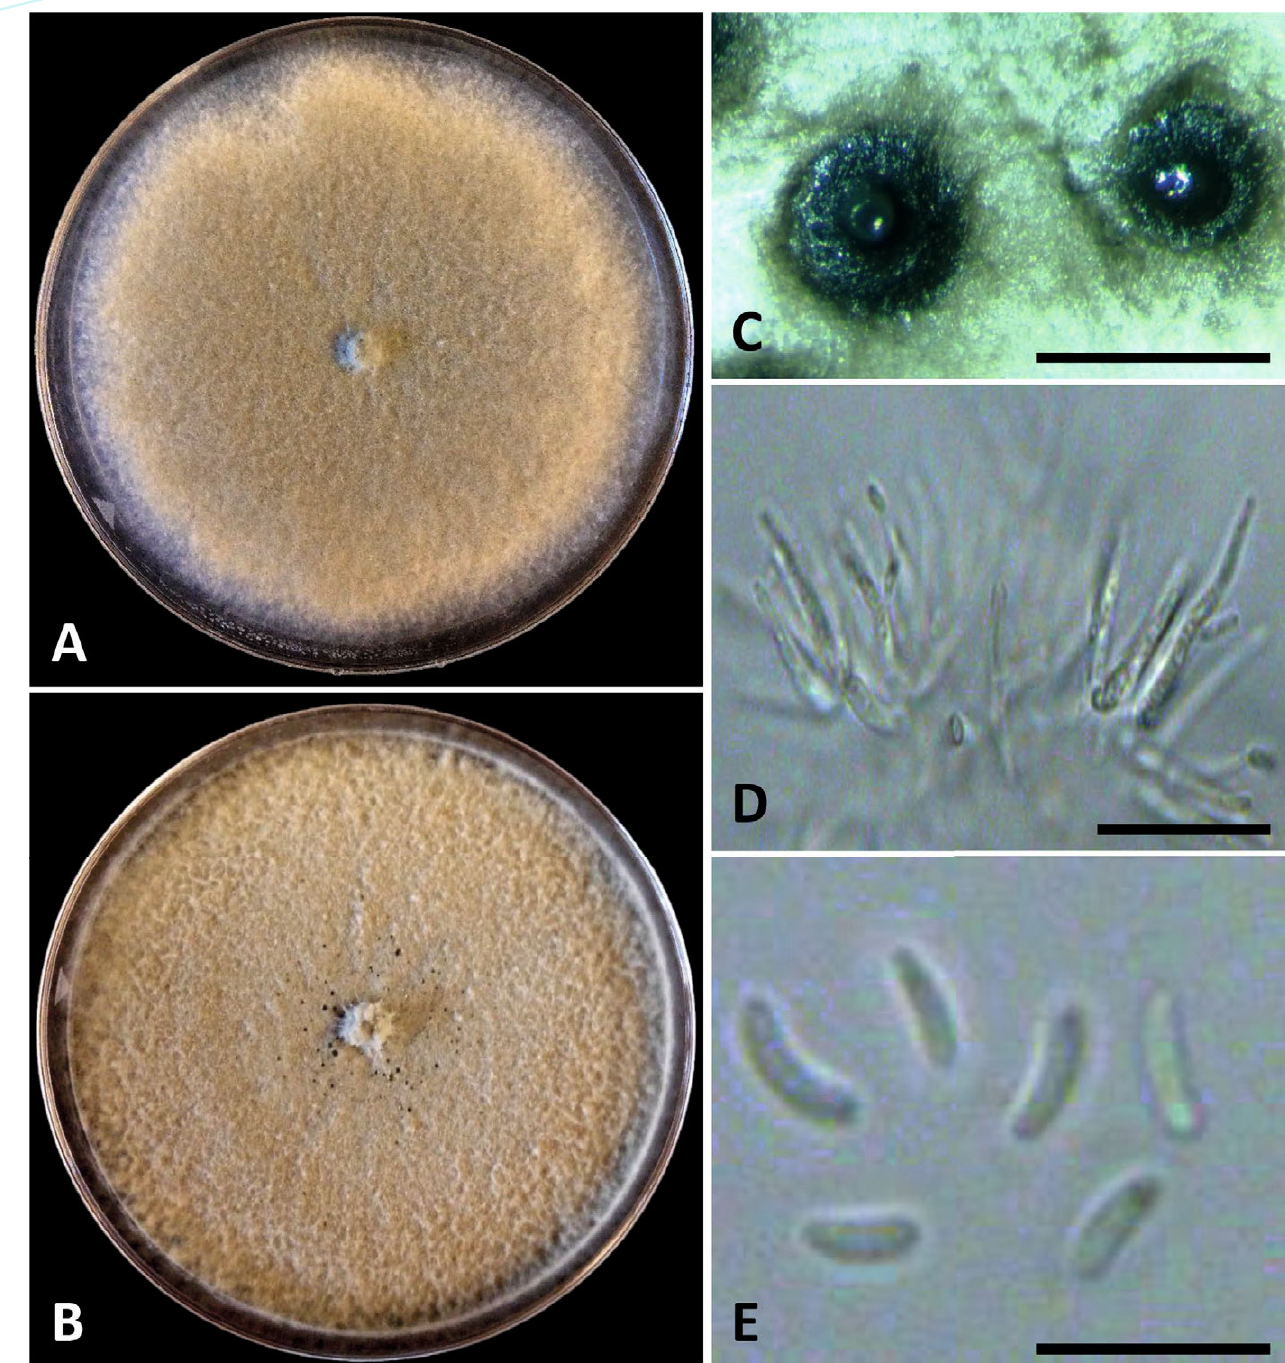
Fig. 14. Cytospora parapistaciae (ex-holotype culture CBS 144506). A. Seven-day-old PDA culture. B. Fourteen-day-old PDA culture. C. Pycnidia. D. (cid:2){(cid:4)(cid:17)(cid:11)(cid:21)(cid:11)(cid:4)(cid:18)(cid:14)(cid:4)(cid:10)(cid:13)(cid:7)(cid:2)(cid:9)(cid:17)(cid:21)(cid:2)(cid:20)(cid:23)(cid:9)(cid:6)(cid:13)(cid:17)(cid:8)(cid:4)(cid:5)(cid:7)(cid:2)(cid:19)(cid:4)(cid:17)(cid:11)(cid:21)(cid:11)(cid:4)(cid:25)(cid:13)(cid:17)(cid:4)(cid:5)(cid:7)(cid:2)(cid:19)(cid:13)(cid:23)(cid:23)(cid:7)(cid:28)(cid:2) E. Conidia. Bars C = 500 μm; D–E = 10